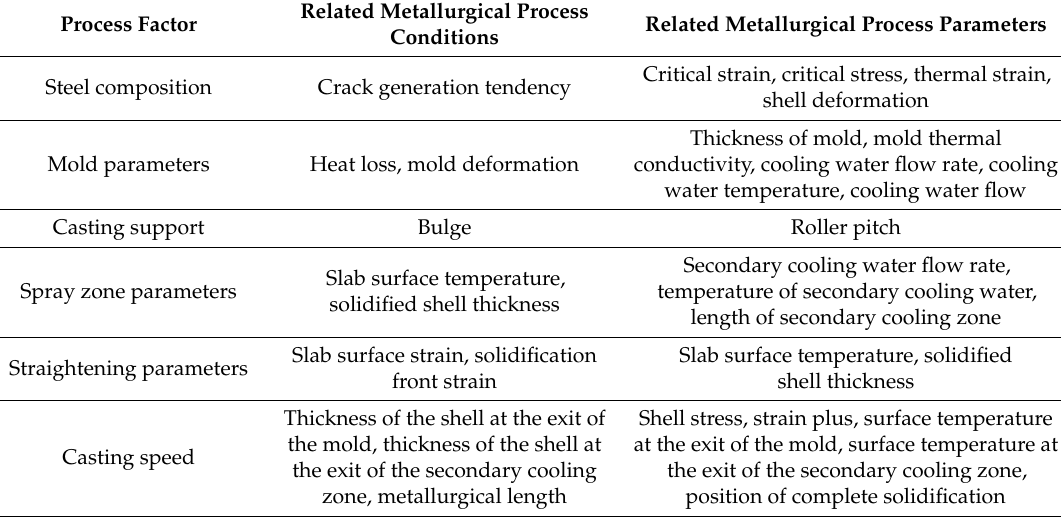
Table 1. Main process factors and related metallurgical process conditions and